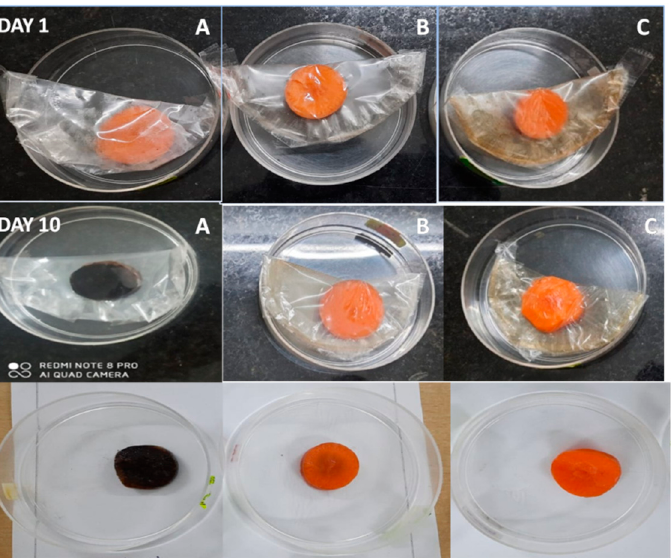
Figure 12. Visual appearances of carrot samples during storage: ( A ) Polyethylene films ( B ) CG ( C ) CG4.